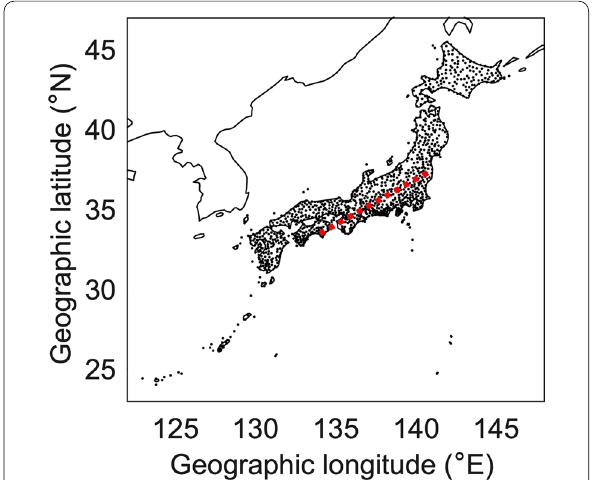
Fig. 1 Distribution of GEONET stations (black dots). The red dashed line indicates the region with most data